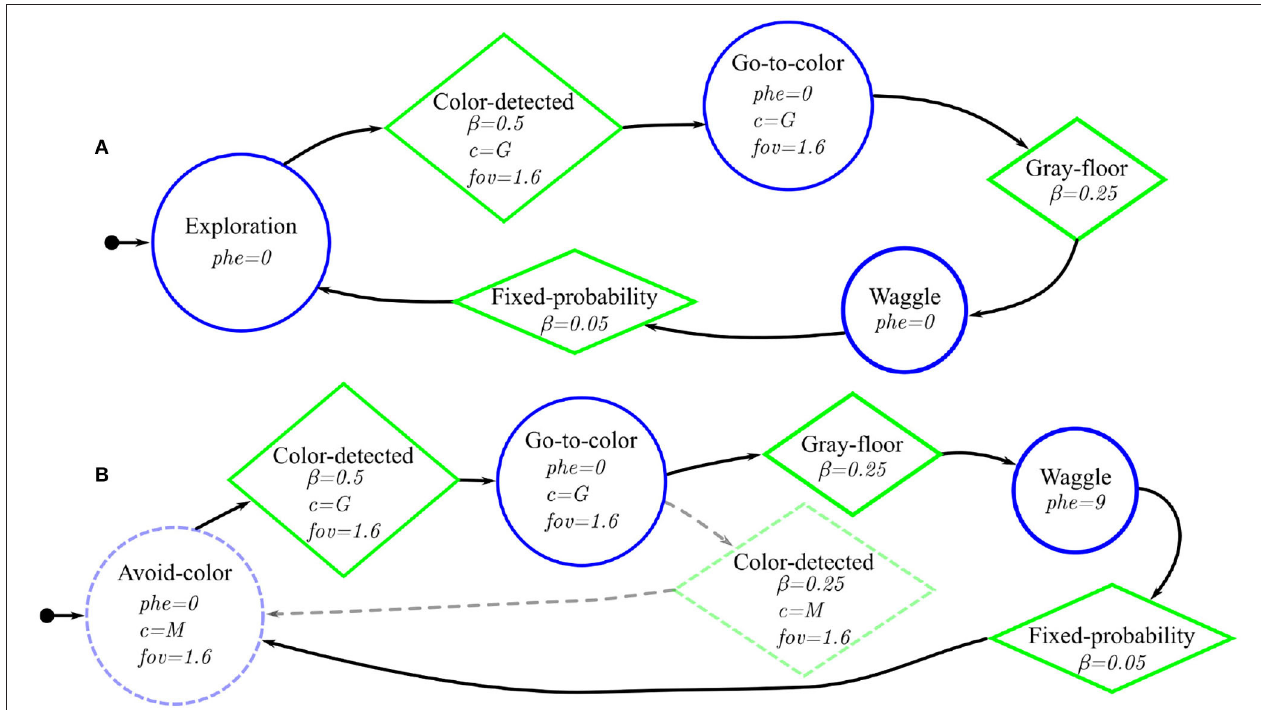
FIGURE 9 | Probabilistic finite–state machines for the two TASKING experiments: (A) Basic- TASKING , and (B) Phormica - TASKING —the difference between the two probabilistic finite–state machines is highlighted with dashed-lines. In both finite–state machines, a circle, a lozenge, and an arrow with a small circle represent the states, transition, and initial state, respectively.